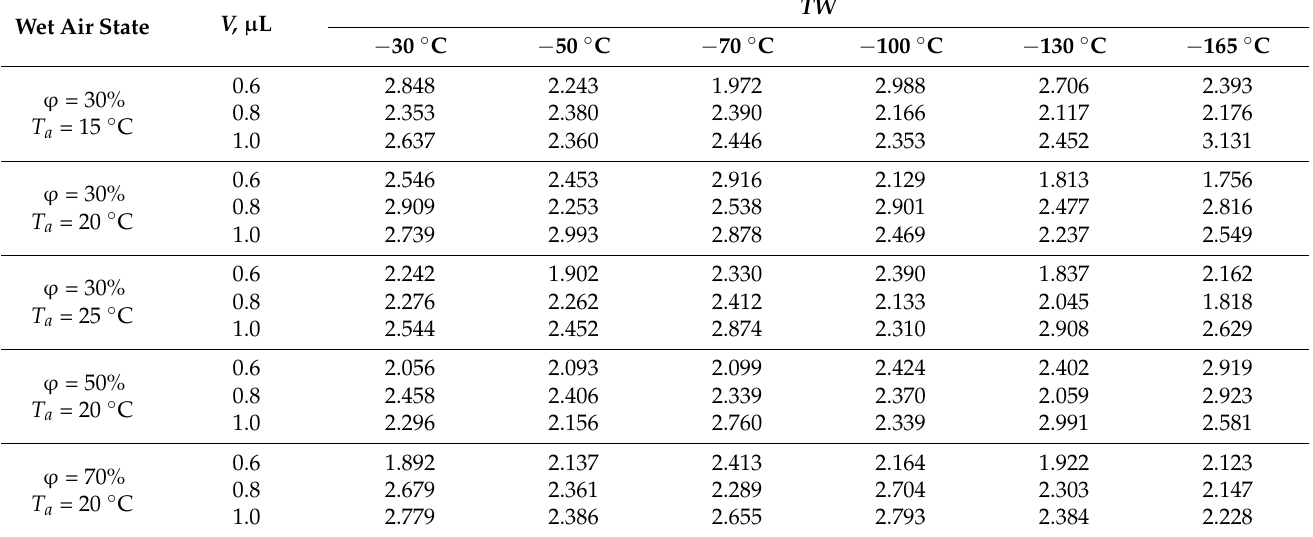
Table 1. The measured initial frost layer thickness l h (mm) .